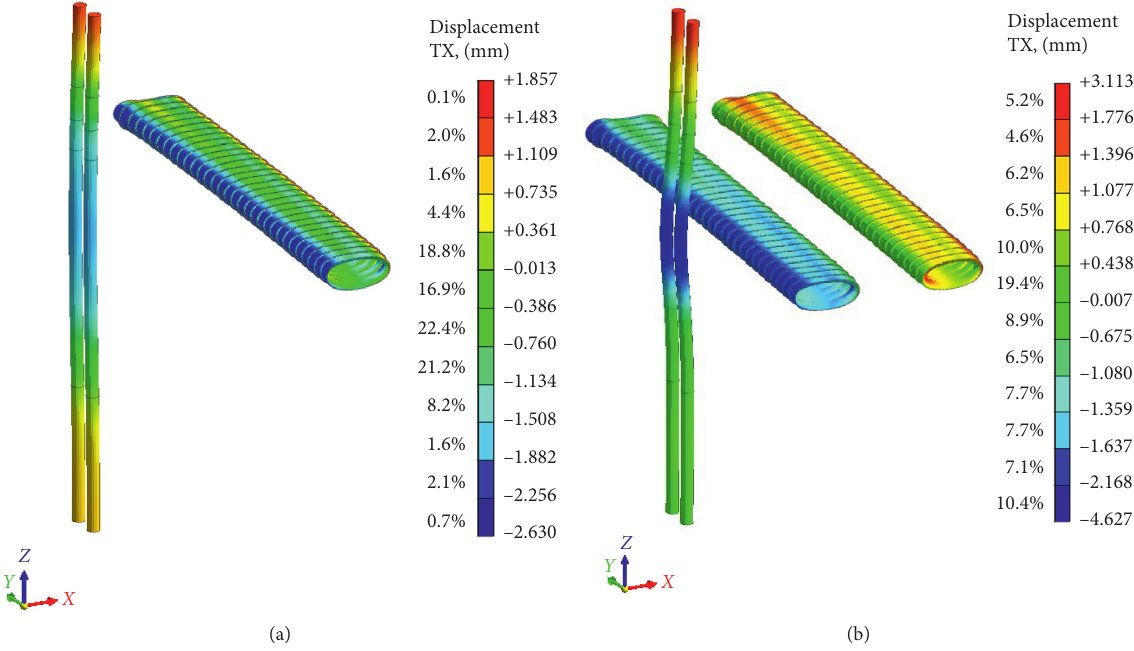
Figure 13: Horizontal displacement of pile and tunnel in condition (a). (a) Right line finished. (b) Left line